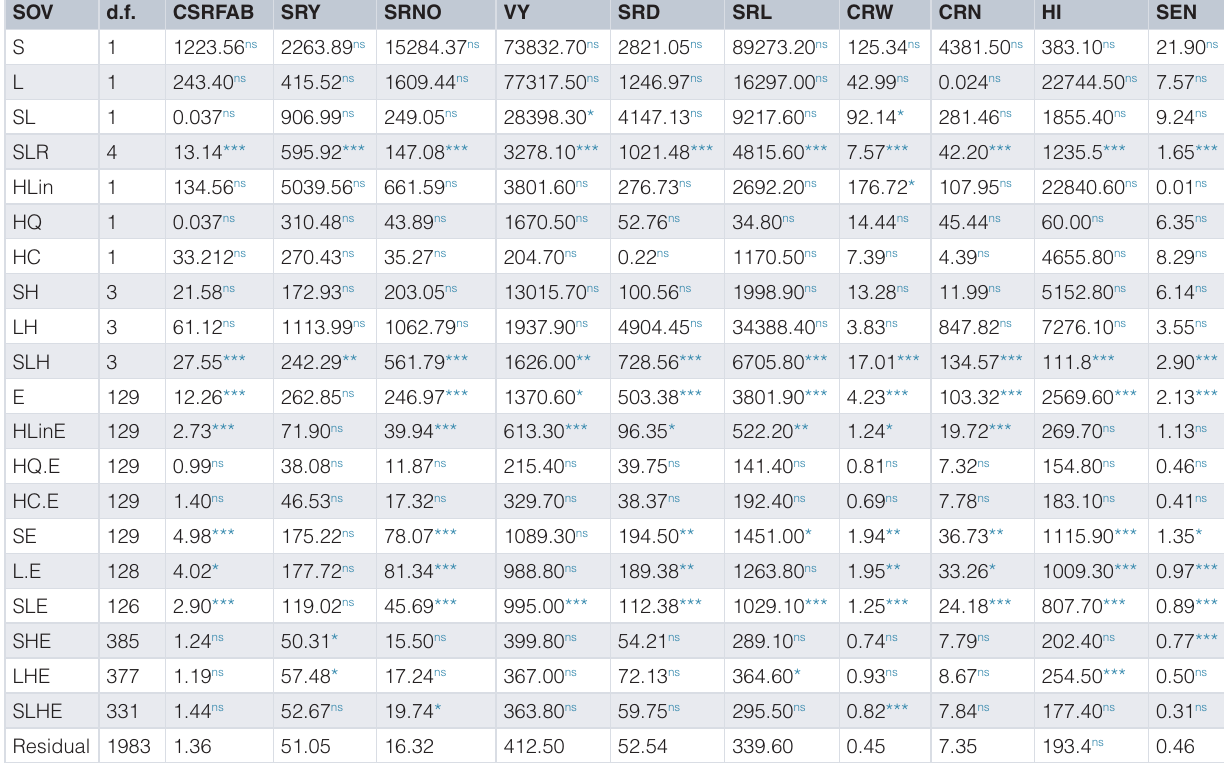
Table 4. Mean squares and F-test of significance for continuous storage root formation and bulking (CSRFAB), storage root yield (SRY) (tons/ha), storage root number (SRNO), vine yield (VY) (tons/ha), storage root diameter (SRD) (mm), storage root